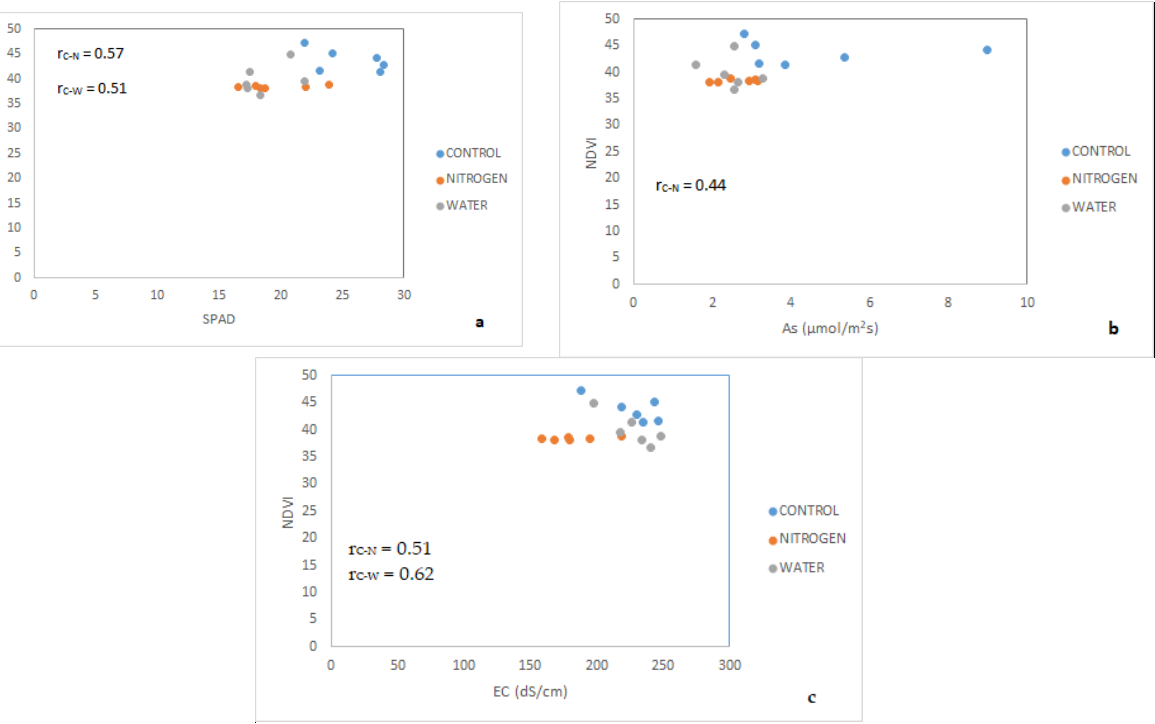
Figure 10. Pearson’s correlation between ( a ) chlorophyll content index (SPAD), ( b ) photosynthetic efficiency (As in μmol/m 2 s) and ( c ) EC (dS/cm).